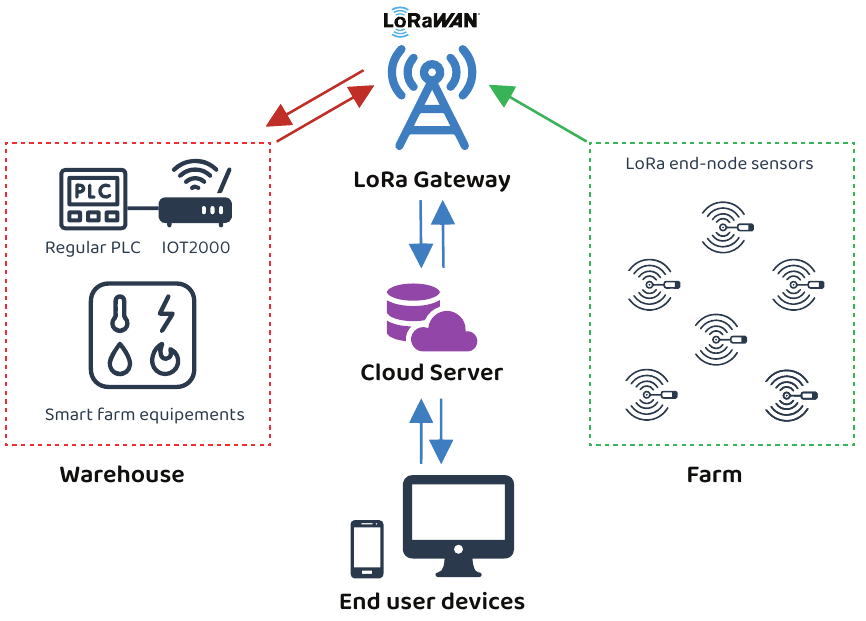
Figure 1. Smart farm system architecture overview. The farm is connected to a LoRa gateway which exchanges data with users via a cloud